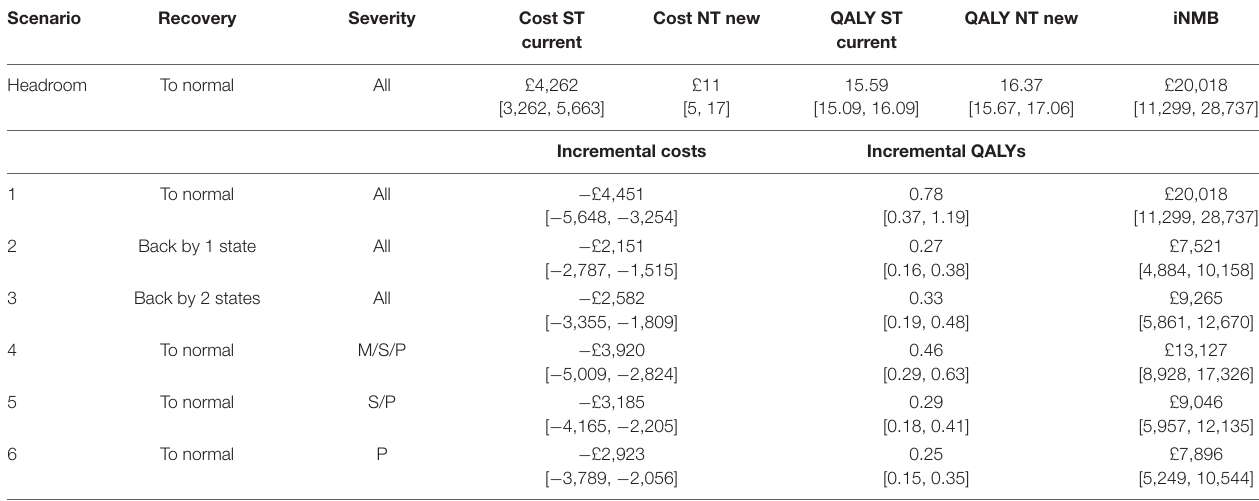
TABLE 4 | Headroom and scenario analysis